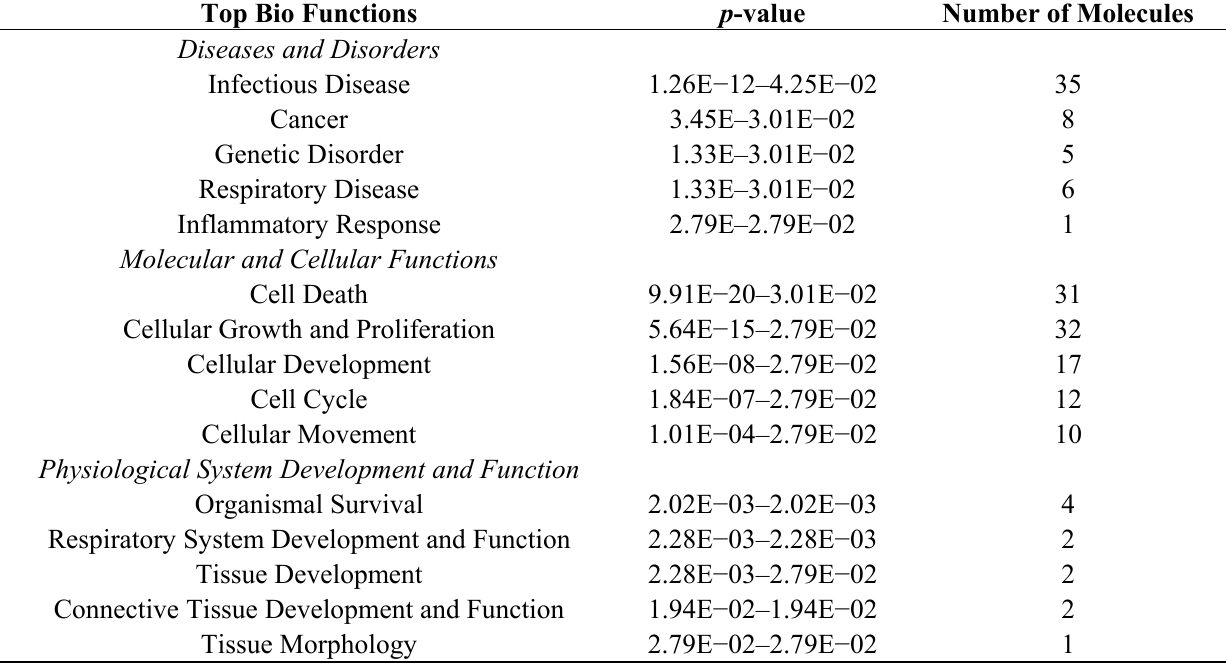
Table 3. Key functions associated with the common network using IPA.